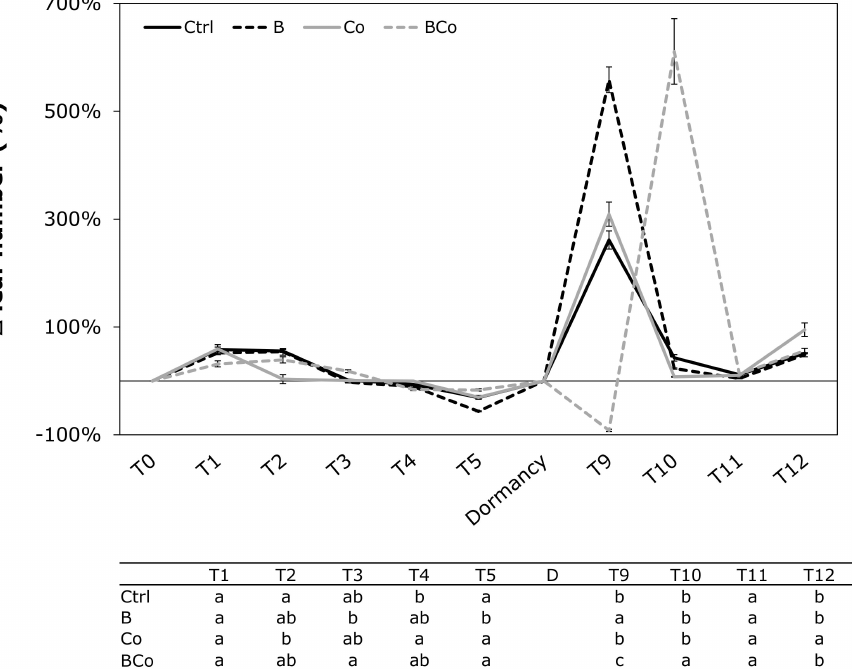
Figure 3. Variation ( ∆ ) in leaf number (%) determined monthly during the 12 months of P. euramericana growth on four different substrates (Ctrl, B, Co, and BCo). Different letters indicate significant differences among the treatments for each sampling time ( p < 0.05) ( n = 10 ± SE). Ctrl: control mix of soil and sand; B: mix of soil and sand + biochar; Co: mix of soil and sand + compost; BCo: mix of soil and sand + biochar + compost. T0 to T12: Sampling times